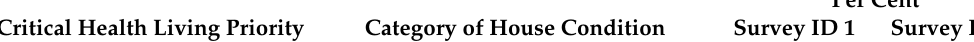
Table A3. Comparison of Survey-Fix 1 and Survey-Fix 2 data for each critical Healthy Living Priority by category of house condition (Good, Fair or Poor) based on house function from